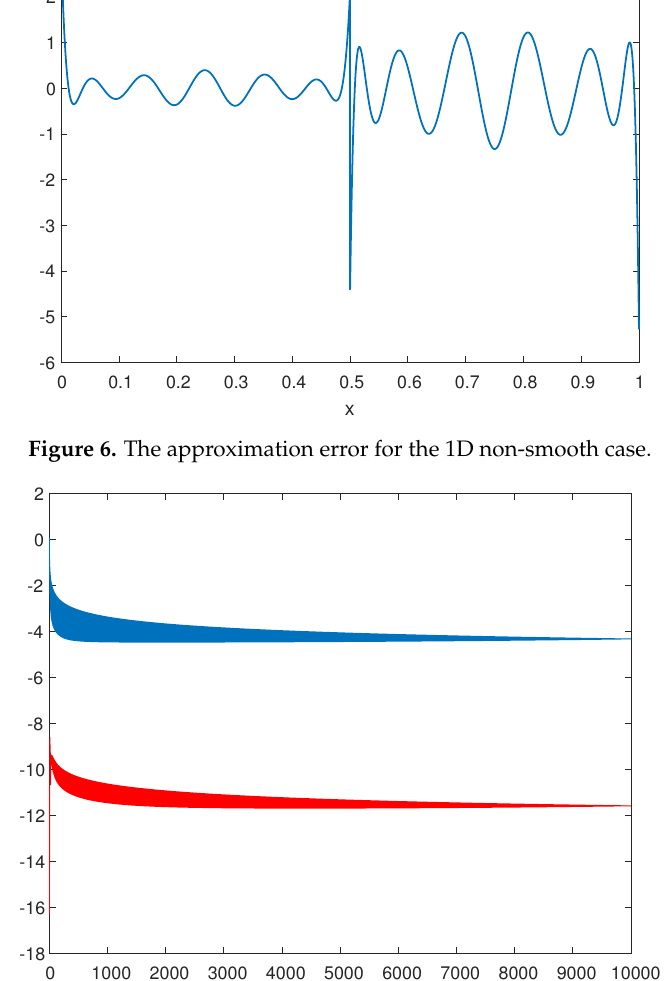
Figure 7. log of the given Fourier coefficients (blue), and of the Fourier coefficients of the approximation 10 error